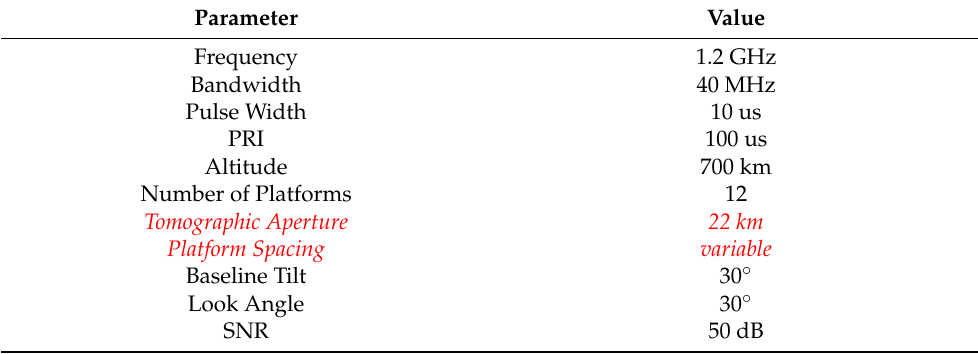
Table 12. Parameters used for Example 9.